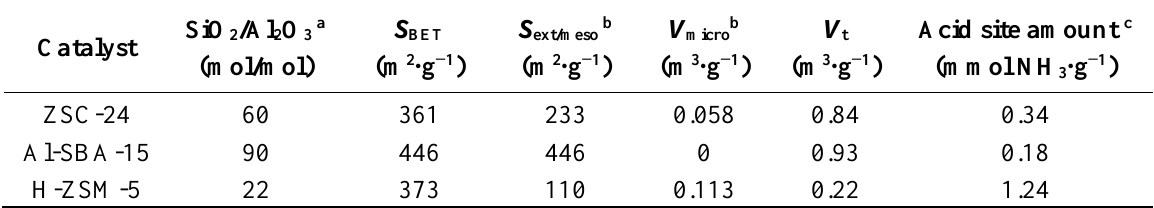
Table 1. Physico-chemical properties of ZSC-24, Al-SBA-15, and commercial H-ZSM-5.